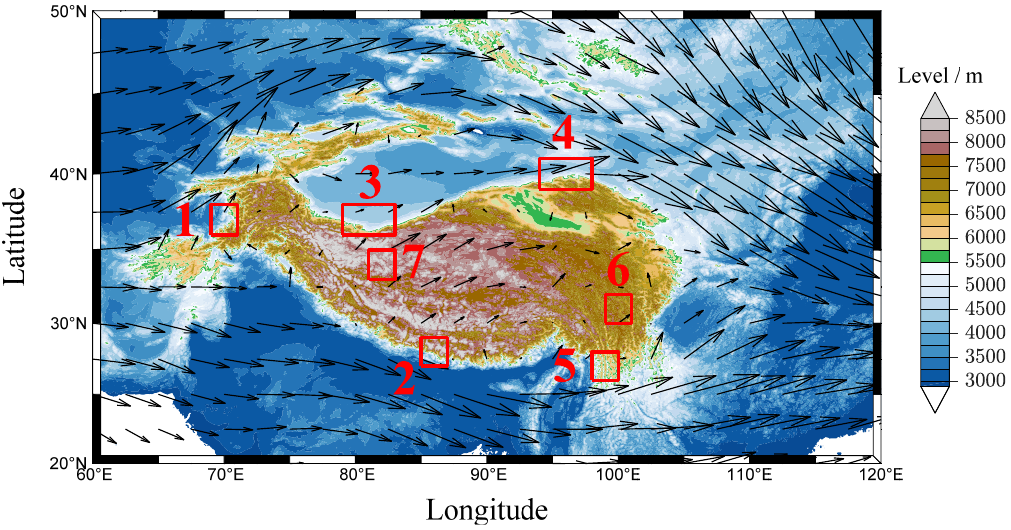
Figure 10. The selected region. The arrow represents the background wind vector of 3 km. Table 3. Region selection and Pearson correlation coefficient between the GW Ep and the background wind/the zonal wind in each region. The correlation coefficient in bold indicates that it passes the 95% significance test.